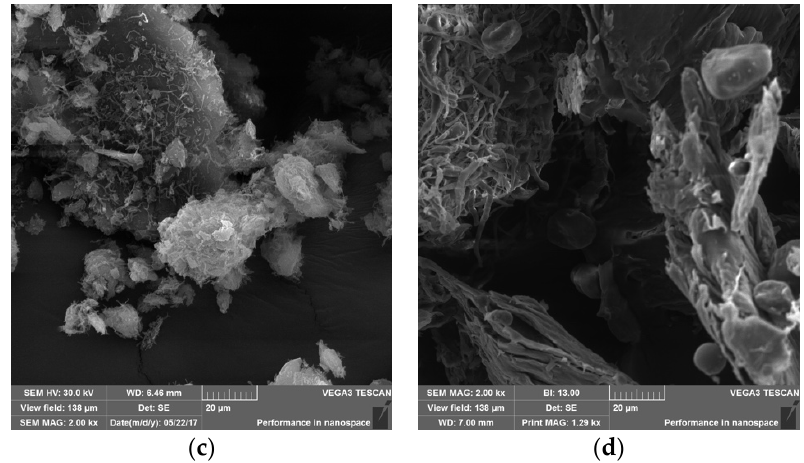
Figure 3. Scanning electron microscopy images of nanofibers. SEM of whole PVA ( a ) and PCL nanofibers ( b ); ground PVA ( c ) and ground PCL ( d ) nanofibers. Magnification 2000×.